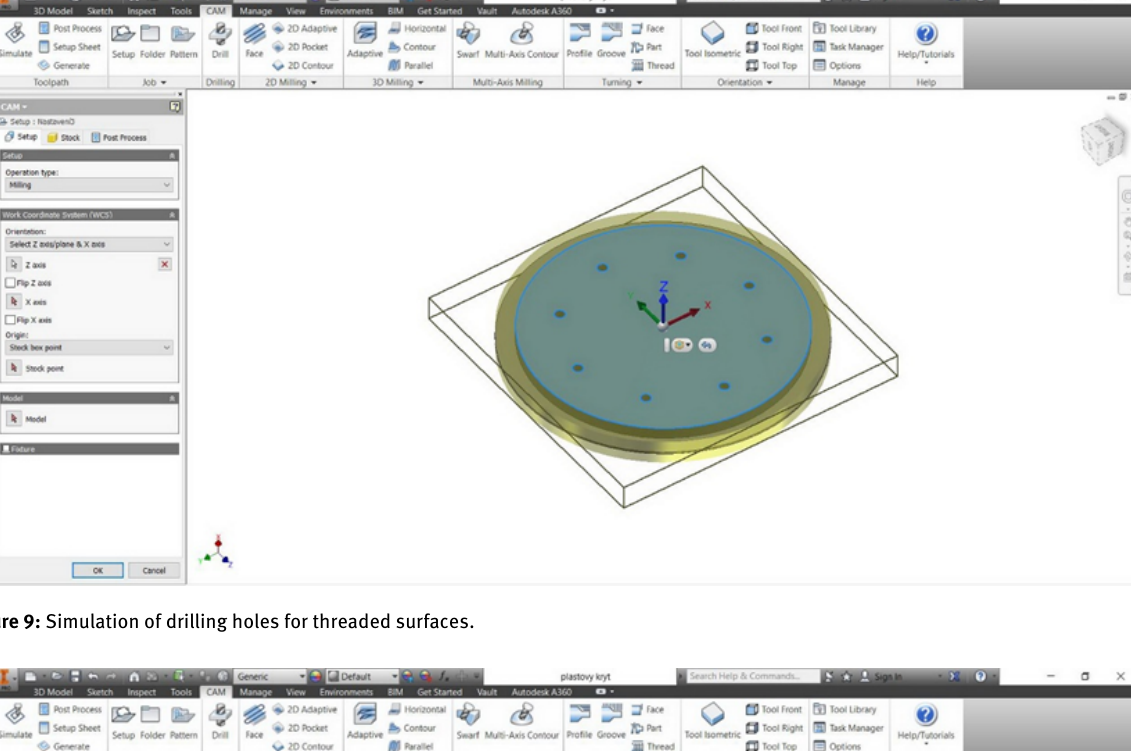
surface on the real component is properly made. The tap angle can also be checked during thread cutting simula- tion, see Figure